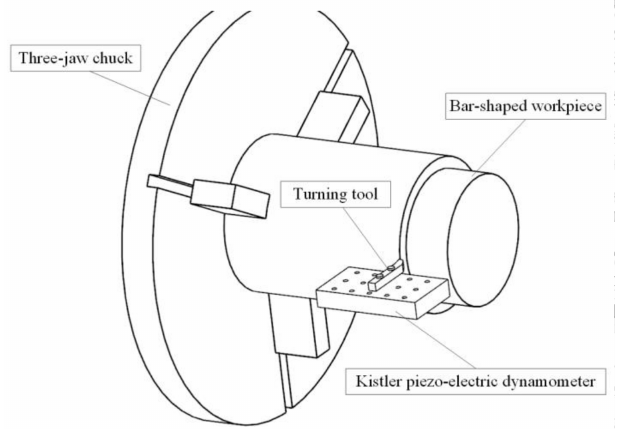
Figure 2. Orthogonal cutting experiments on the CK7525 CNC Lathe.